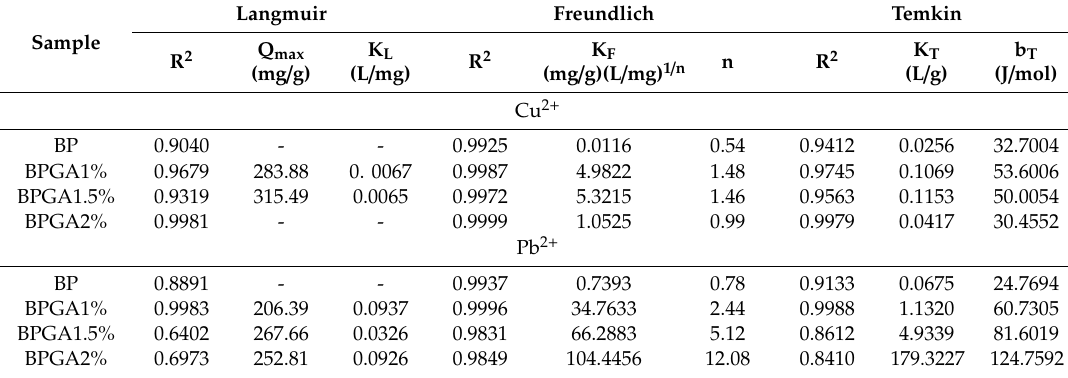
Isotherm model parameters for the adsorption of metal ions onto the sample adsorption